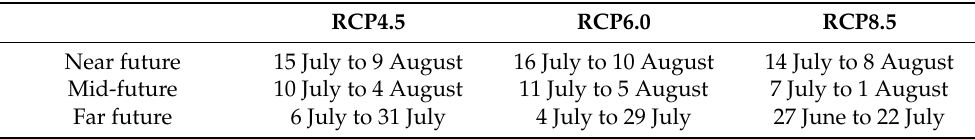
Table 2. Calculation period of HSWI under 3 RCPs in different decades of the 21st